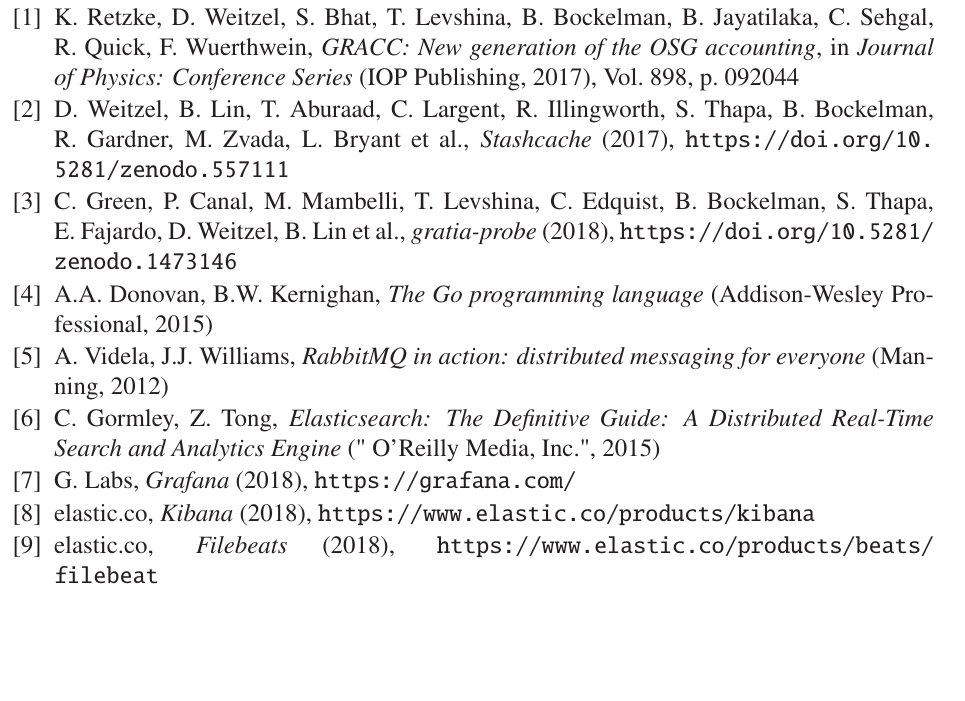
Figure 4. HTCondor TCP Dataflow